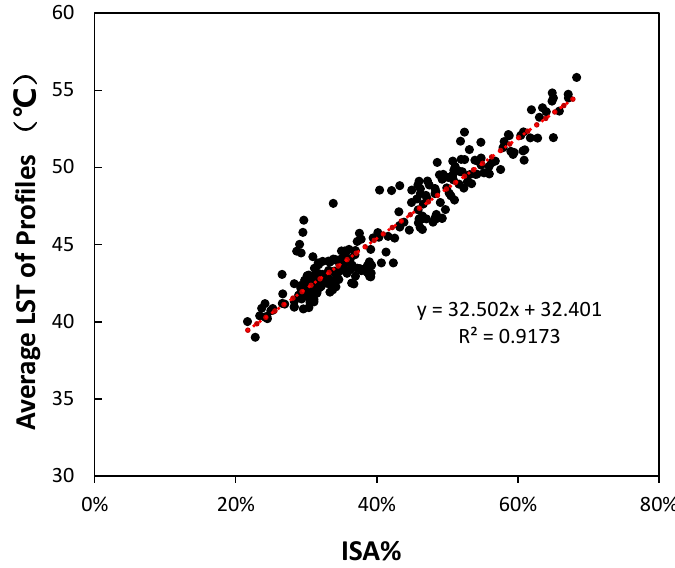
Figure 14. Scatterplot of average LST of profiles and